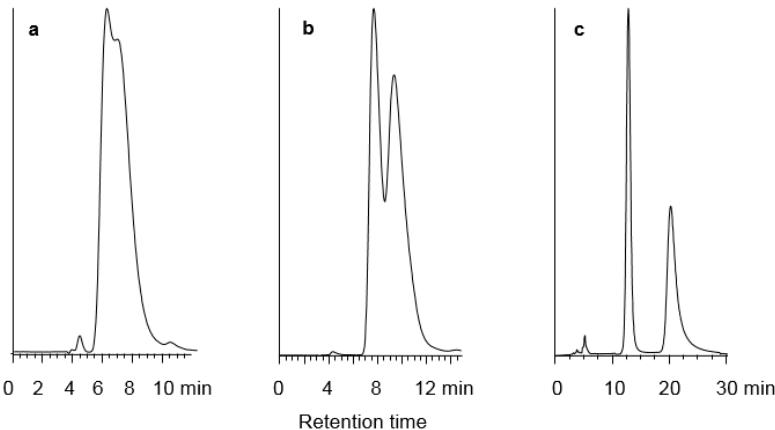
Figure 3. Chromatographic resolution of compound 16 . ( a ) on PMBC-S, mobile phase hexane/2-propanol 90/10 ( v / v ); ( b ) on PMBC-Im E, mobile phase hexane/2-propanol 90/10 ( v / v ); ( c ) on PMBC-Im E, mobile phase heptane/chloroform 75/25 ( v / v ).